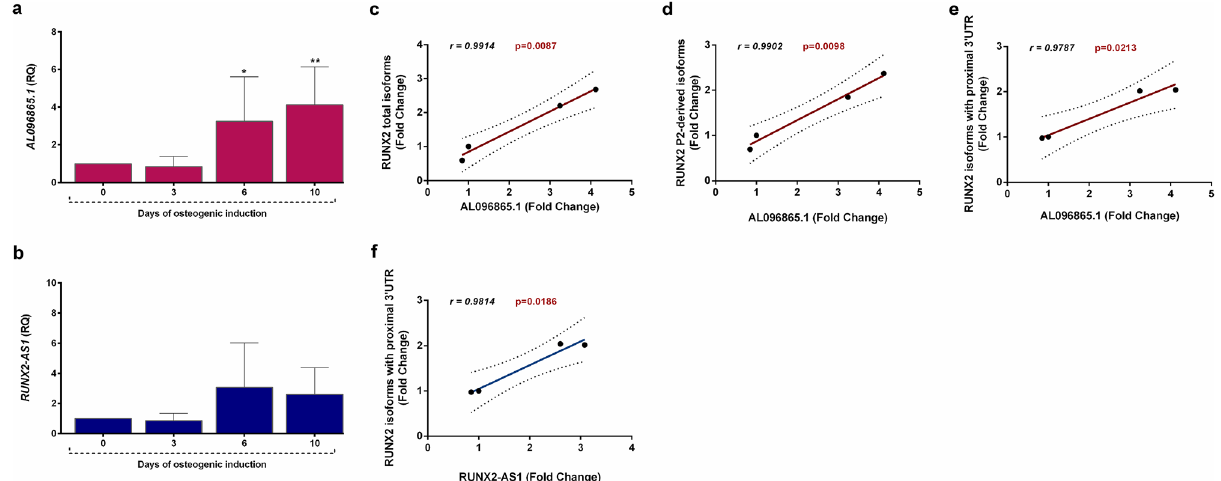
Figure 6. lncRNAs expression during osteogenic induction in vitro . (a,b) The bar graphs show the expression of AL096865.1 (a) and RUNX2-AS1 (b) measured by real time PCR, in cells undergoing osteogenic induction up to 10 days. The fold change of expression levels is expressed as “relative quantity” (RQ), calculated according to the ΔΔCt method, setting the day 0 (when the standard growth medium has been replaced with the osteogenic medium) value as reference. All data are expressed as mean fold change ± standard deviation across replicates. *p ≤ 0.05; **p ≤ 0.01. (c–f) The line graphs draw the linear regressions during the first phases of osteogenic induction (up to 10 days) of the relative expression levels of AL096865.1 with total RUNX2 levels (c) , RUNX2 P2-derived transcripts (d) and RUNX2 splice variants containing the proximal 3’UTR (e) , and of RUNX2-AS1 with the group of RUNX2 isoforms containing the proximal 3’UTR (f) . Pearson correlation was evaluated and the Pearson correlation coefficient (r value) and p-value (p) were